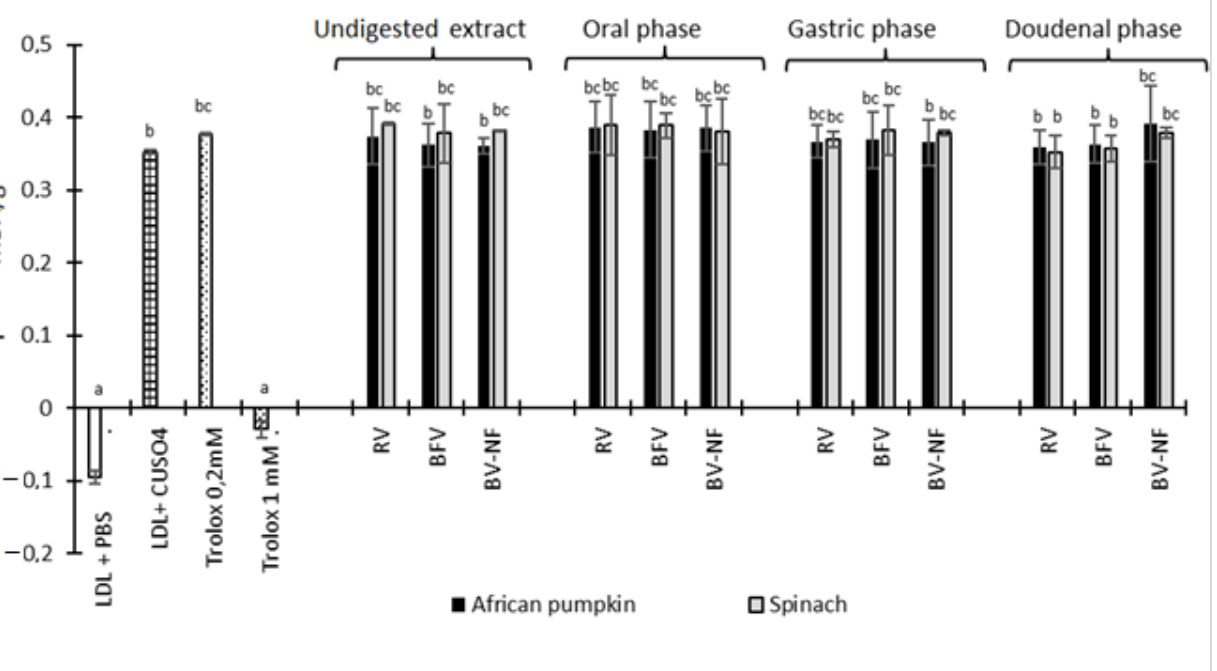
Figure 3. Inhibition of copper-mediated human LDL oxidation by African pumpkin and spinach extracts. LDL + PBS contains LDL and phosphate-buffered solution, LDL + Cu 2 + contains LDL and Cu 2 + only. All samples contain LDL and Cu 2 +. Raw vegetable (RV), boiled filtered vegetable (BFV), boiled vegetable—not filtered (BV-NF). Trolox 0.2 mM and 0.4 mM were used as reference antioxidant standards. Alphabets in superscripts on bars show significant differences at p < 0.05.